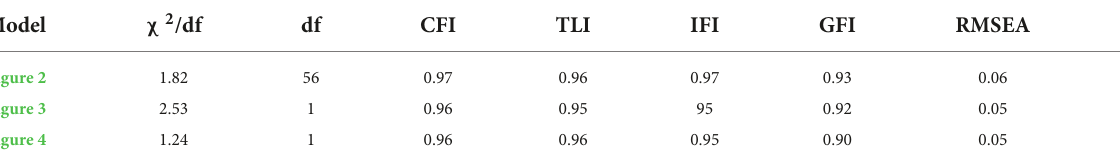
TABLE 3 Goodness of fit indices for the models.